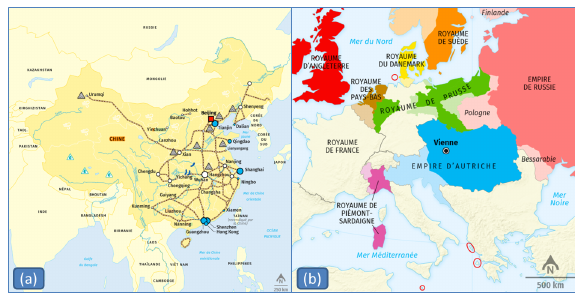
Figure 7: Some maps are complex to label: (a) hydrography is drawn in China but not in the other countries; (b) There is only one city in the map (Vienna).